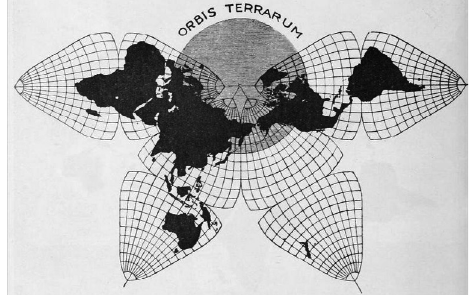
Fig. 12. Three projection types used for the construction of Cahill’s map (1 – conformal,